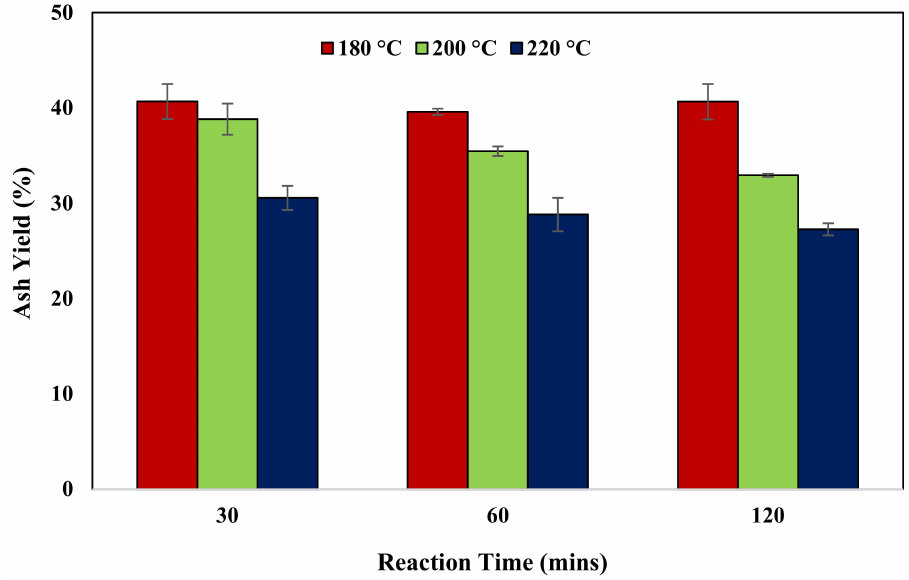
Figure 8. Effect of the process conditions on the ash yield of hydrochar in the